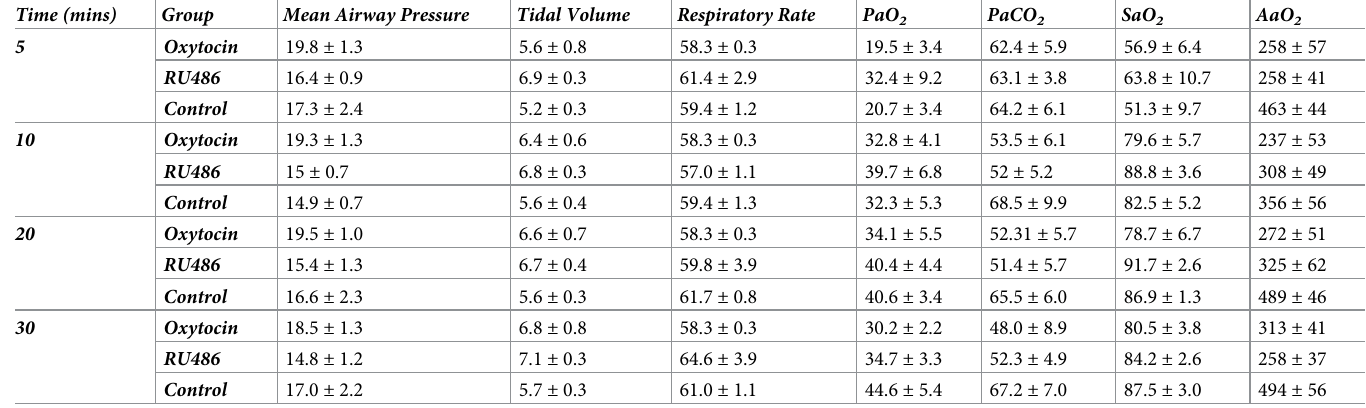
Table 2. Arterial blood gas parameters. Time